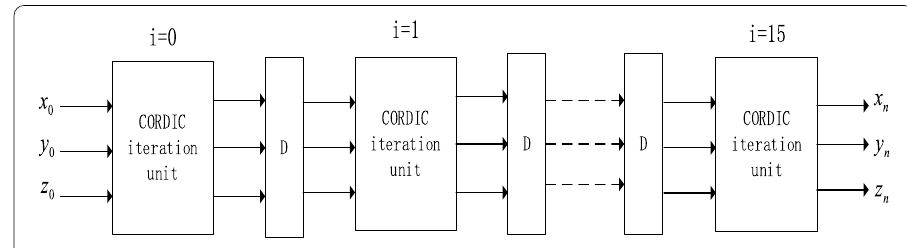
Fig. 4 Block diagram of complex multiplication based on